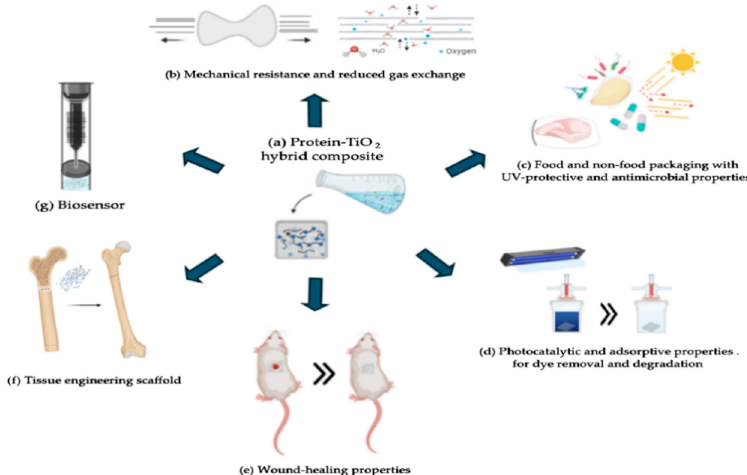
Figure 2. Protein–TiO 2 hybrid composites ( a ) with enhanced mechanical and reduced gas exchange ( b ) and their applications: as food and non-food packaging with UV-protective and antimicrobial properties ( c ), photocatalytic activity for dye removal and degradation ( d ), wound-healing material ( e ), tissue engineering scaffolds ( f ), and for the development of biosensors ( g ) (adapted from Lin et al. [3], Fan et al. [27], Alizadeh-Sani et al. [28], Emregul et al. [70], Ferreira et al. [71]) (figure created with BioRender.com).